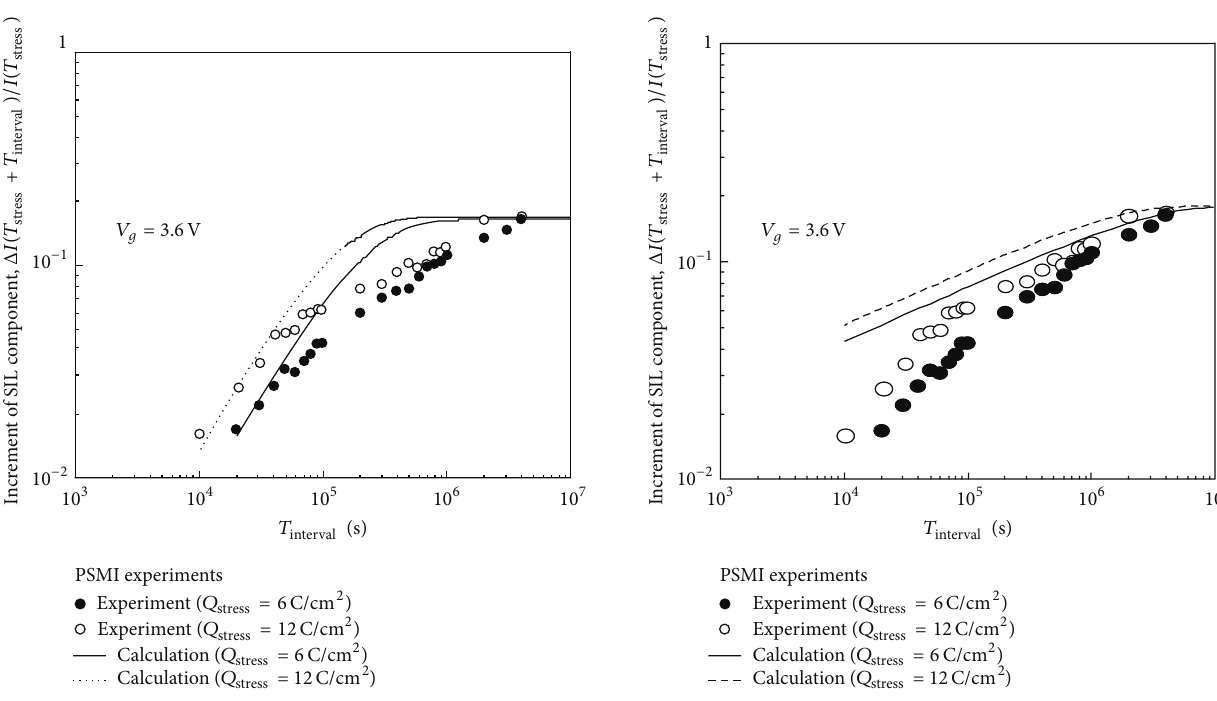
+ 𝑇 )/ stress interval = 12C/cm 2 stress